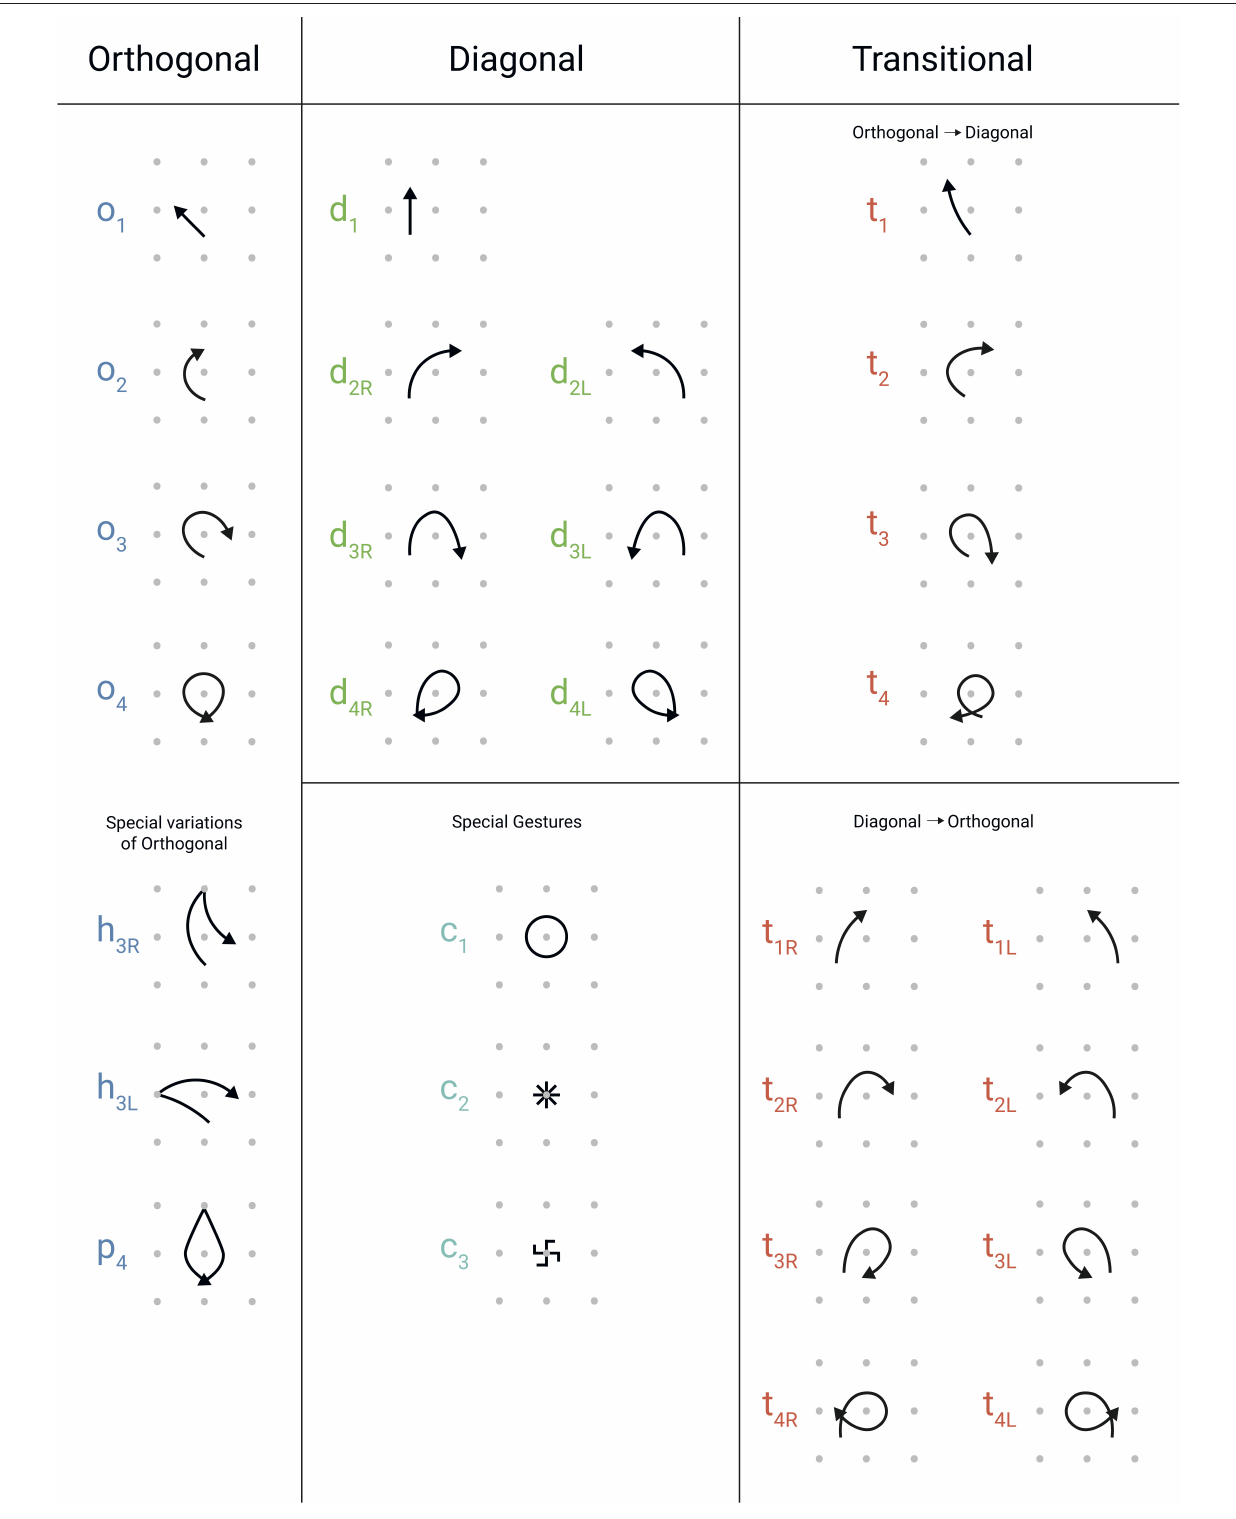
Frontiers in Psychology | www.frontiersin.org